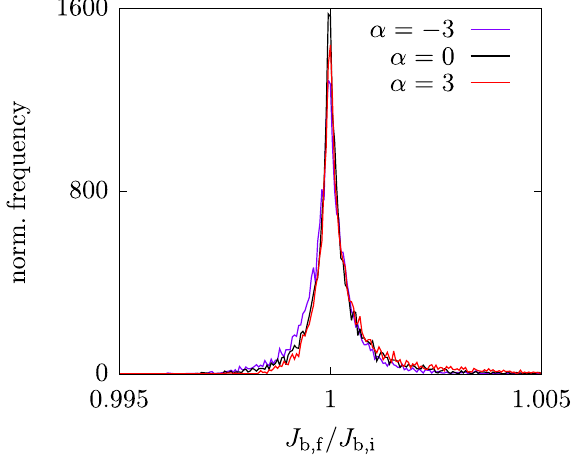
=J for three values of α . b ; f b ; i 10 4 , h I 1 × 10 − 4 , p ¼ x; i i ¼